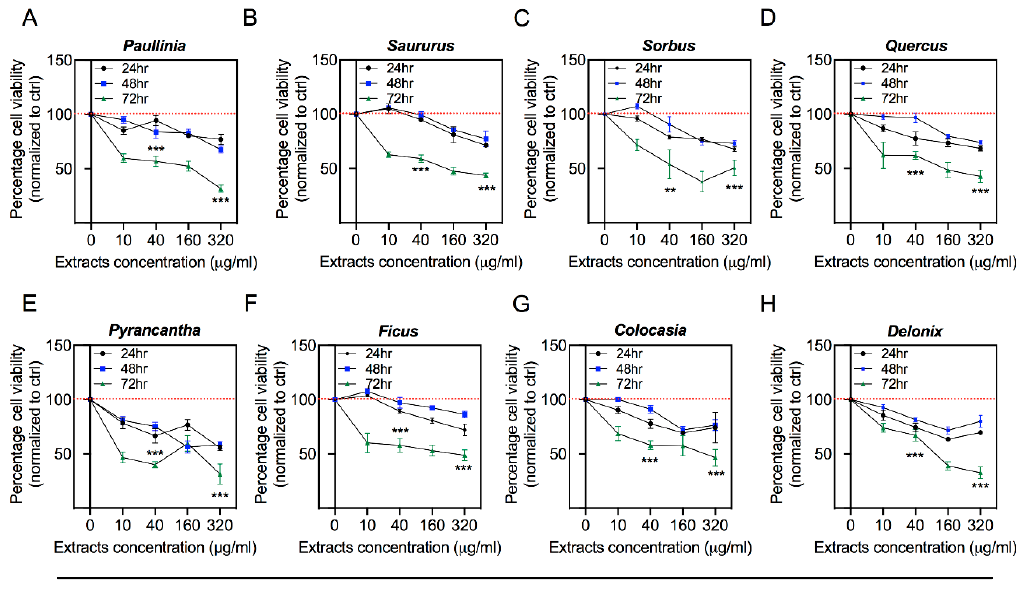
Figure 3. Cell viability screening analysis of different extracts from eight medicinal plants in human breast carcinoma MDA-MB231 cells. The alamarBlue assay was performed in Paullinia ( A ), Saururus